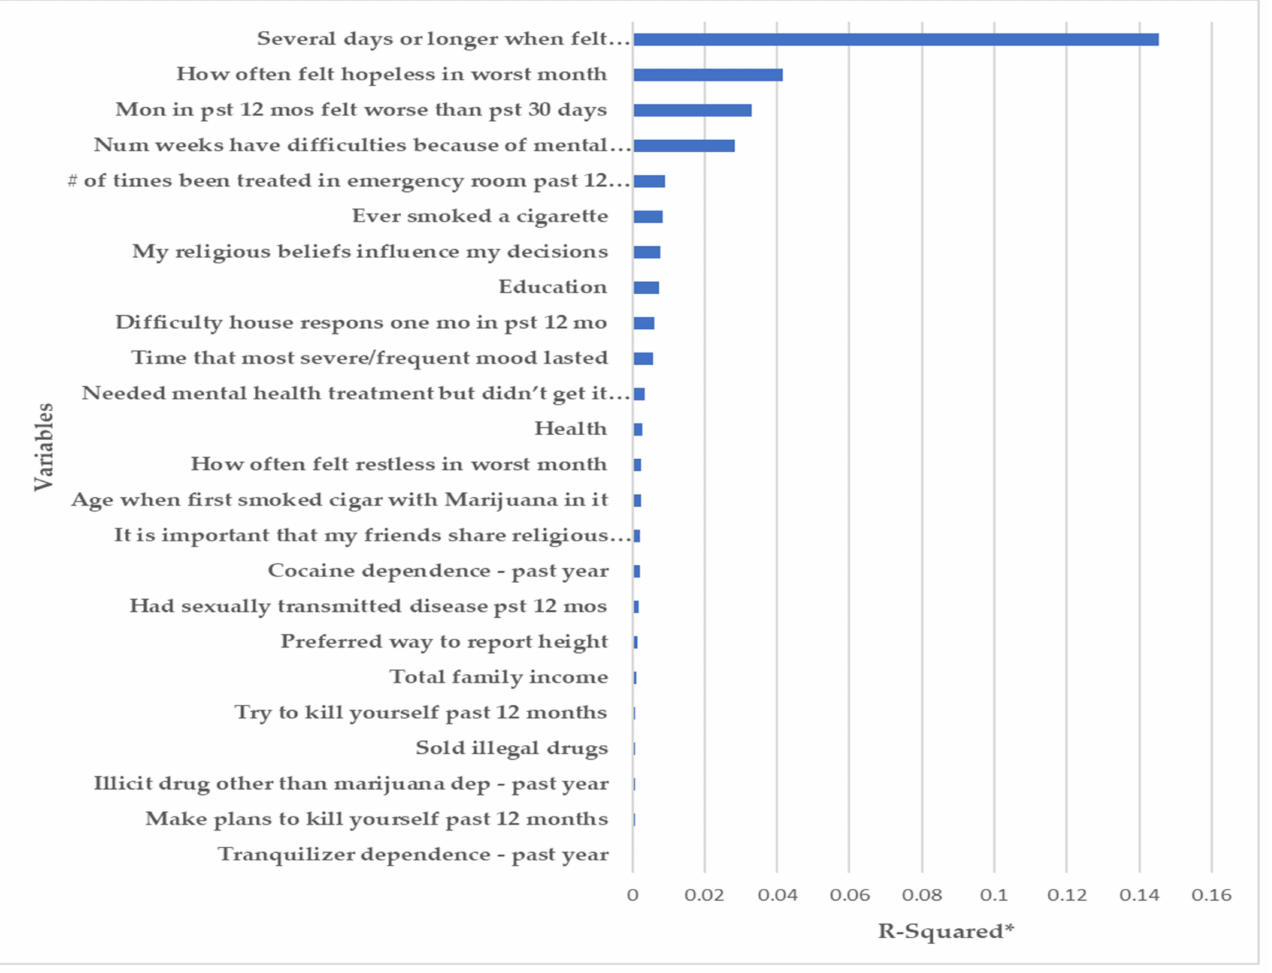
Figure 2. Importance plot for depression (* a larger R-squared value means that a variable explains a larger percentage of the variation in the outcome